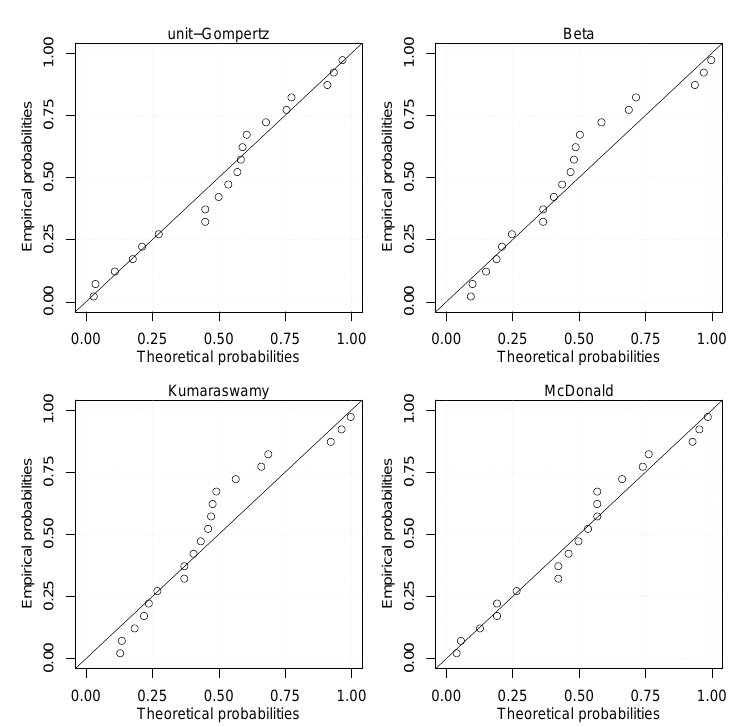
Figure 4 – PP-Plots of the fitted distributions — Data Set I. Finally, the probability-probability plots for all fitted models are shown in Figures 4 and 5. These plots show that the unit-Gompertz distribution provides the good fit to these data sets compared to the other two models, beta and Kumaraswamy